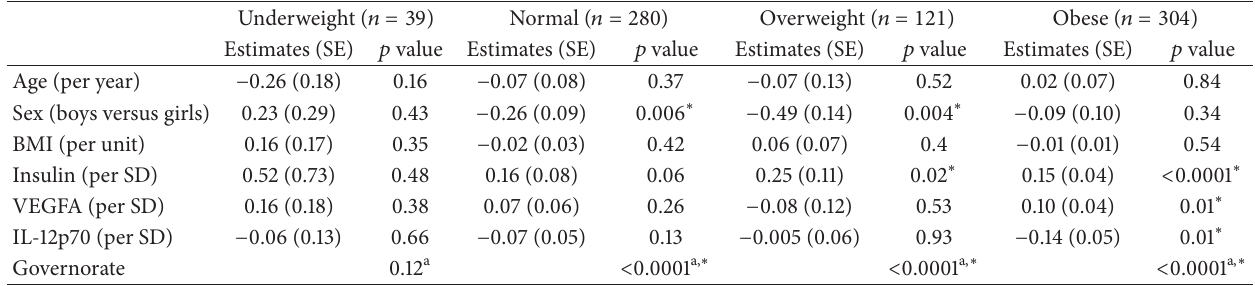
Table 3: Analysis of the association between salivary glucose, demographic factors, and biomarkers in a subset of 744 children stratified by body weight category. Values marked with an asterisk are statistically significant ( 𝑝 < 0.05 ).